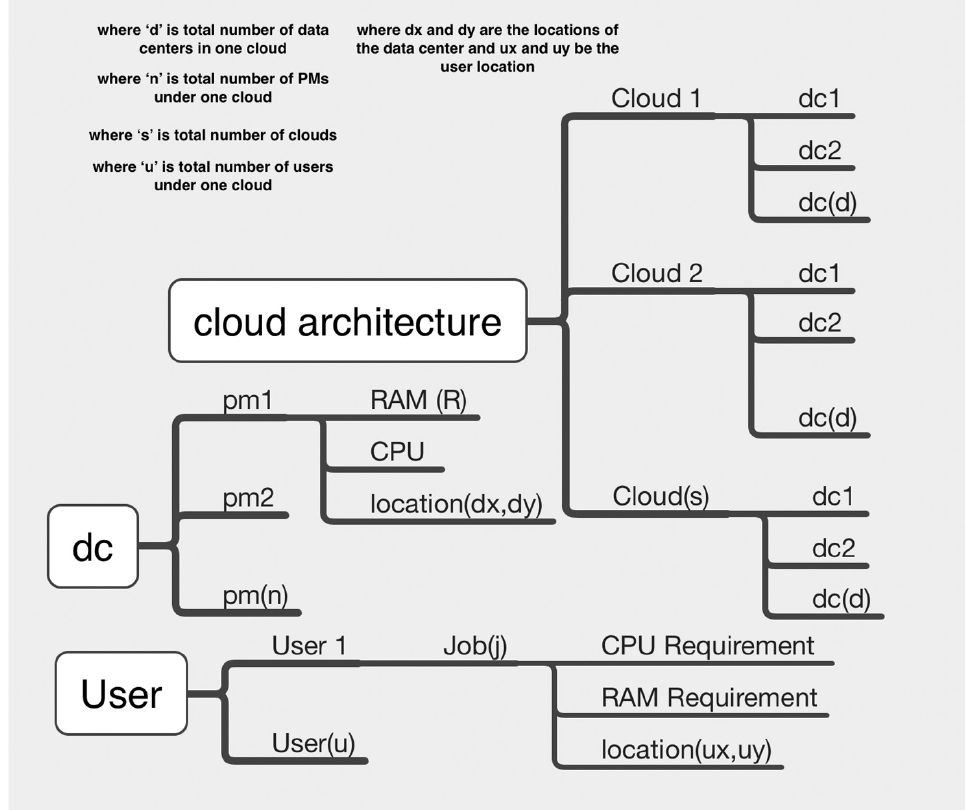
Figure 1. Components of proposed work.